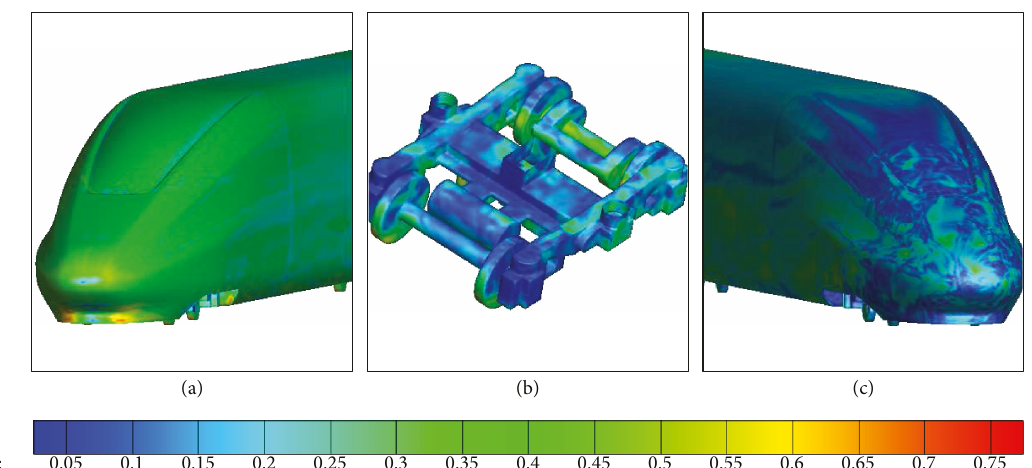
Figure 4: Y plus (free fl ow speed: 97.22m/s): (a) head car, (b) fi rst bogie, and (c) tail